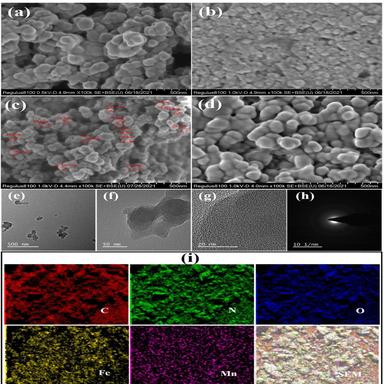
SEM images of Fe NPs (a), Mn NPs (b), optimized (c) and unoptimized (d) Fe–Mn NPs; TEM (e, f), and High-resolution TEM images (g) of optimized Fe–Mn NPs.; electron diffraction pattern (h) and elemental mapping images (i) of optimized Fe–Mn NPs.